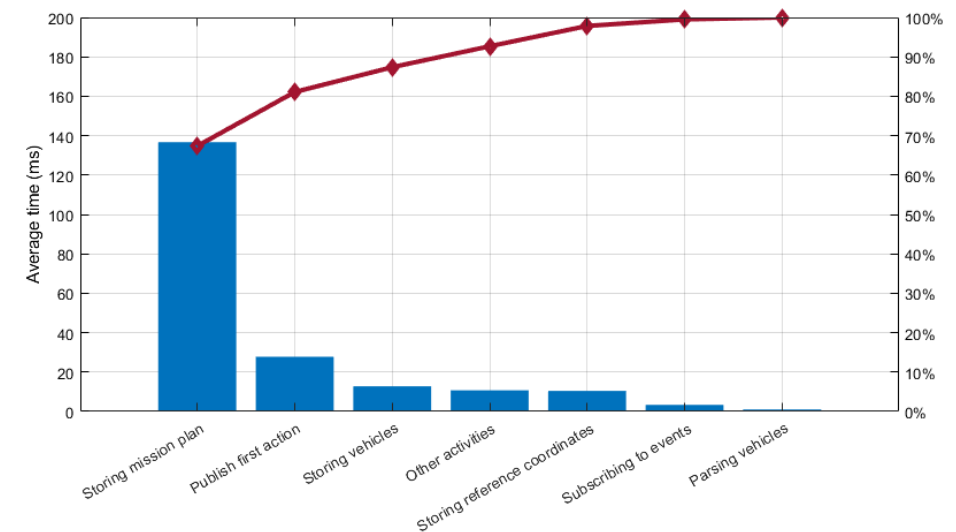
Figure 30. Pareto chart for the average distribution of time for each activity performed by the MTRR when starting a mission without consideration for the logging of the actions in the mission plan.